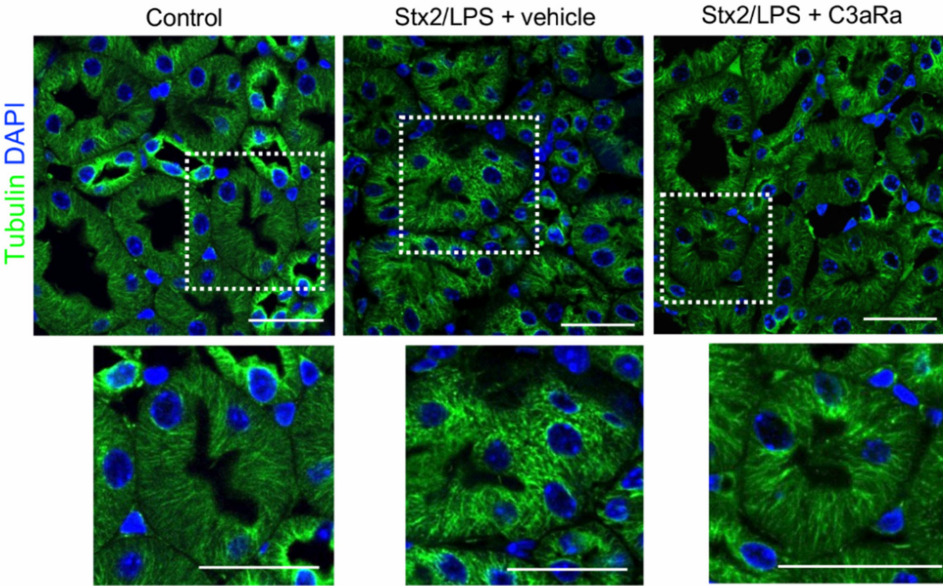
Figure 5. Treatment with the C3aR antagonist limits tubulin alterations in proximal tubules of Stx2/LPS mice. Representative images of tubulin expression (green) in control and Stx2/LPS mice receiving vehicle or C3aRa. Nuclei were stained with DAPI (blue). Scale bars: 20 µ